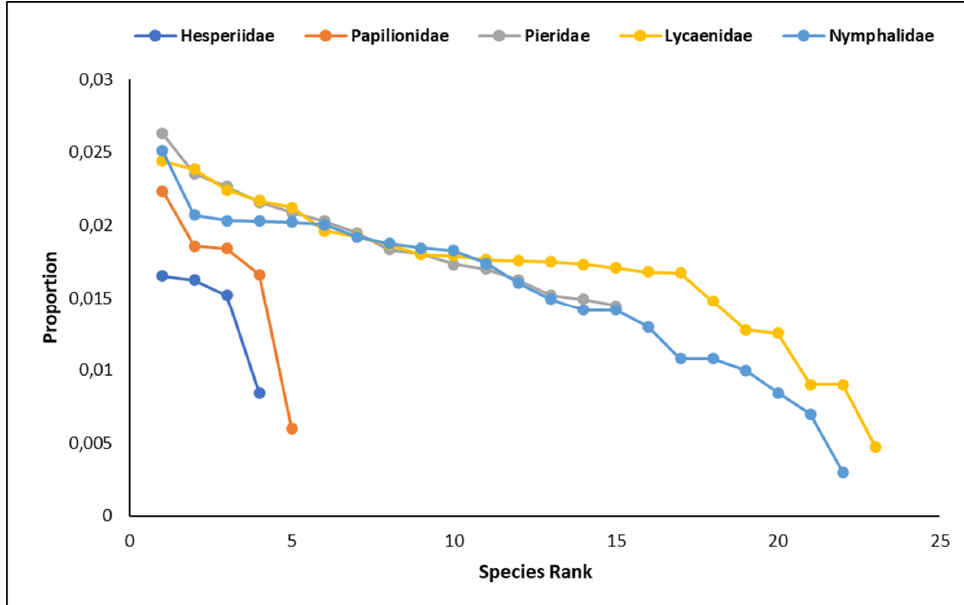
Figure 6B. Family-wise Rank-abundance curve or Whittaker plot of butterfly community in the study area